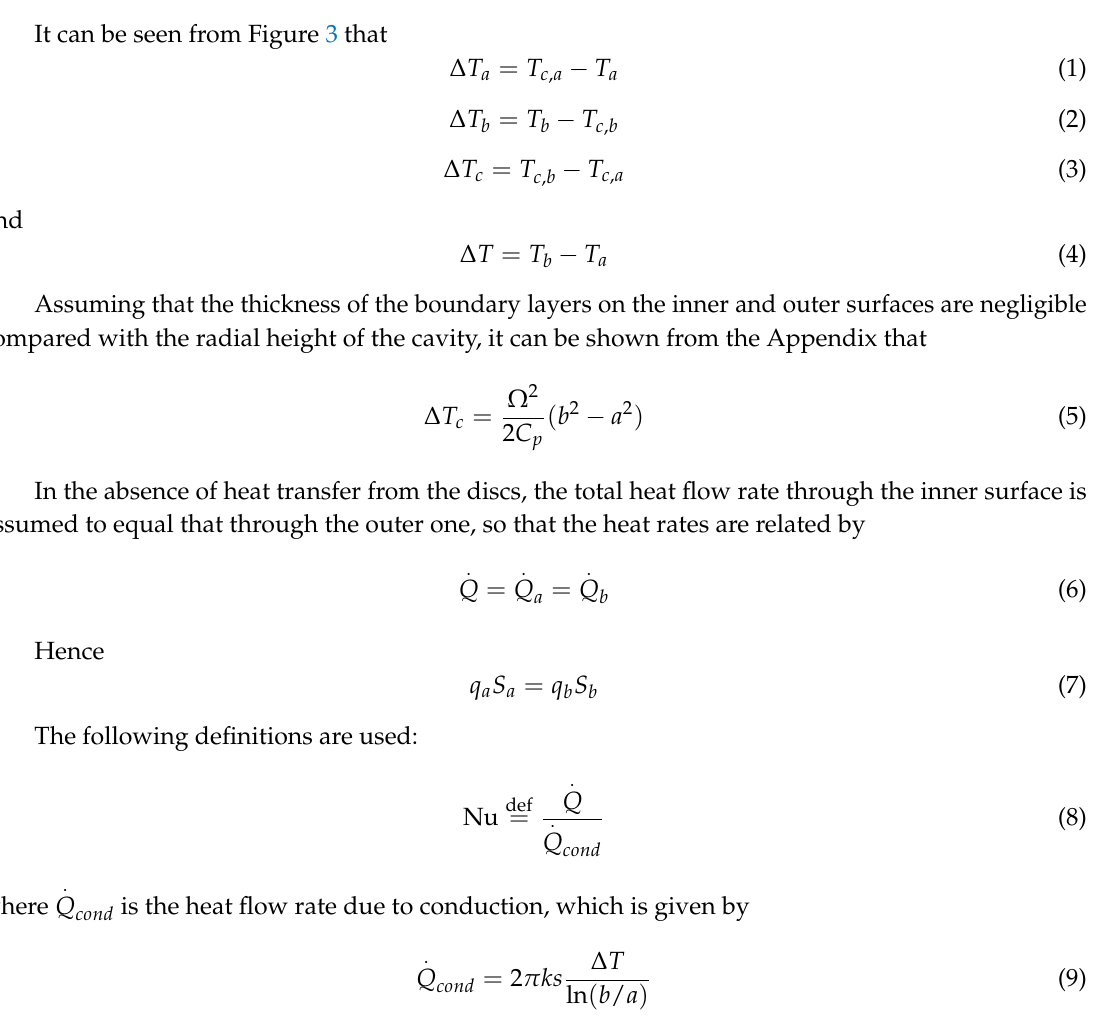
Figure 3. Simplified diagram of temperature distribution inside closed cavity [2].